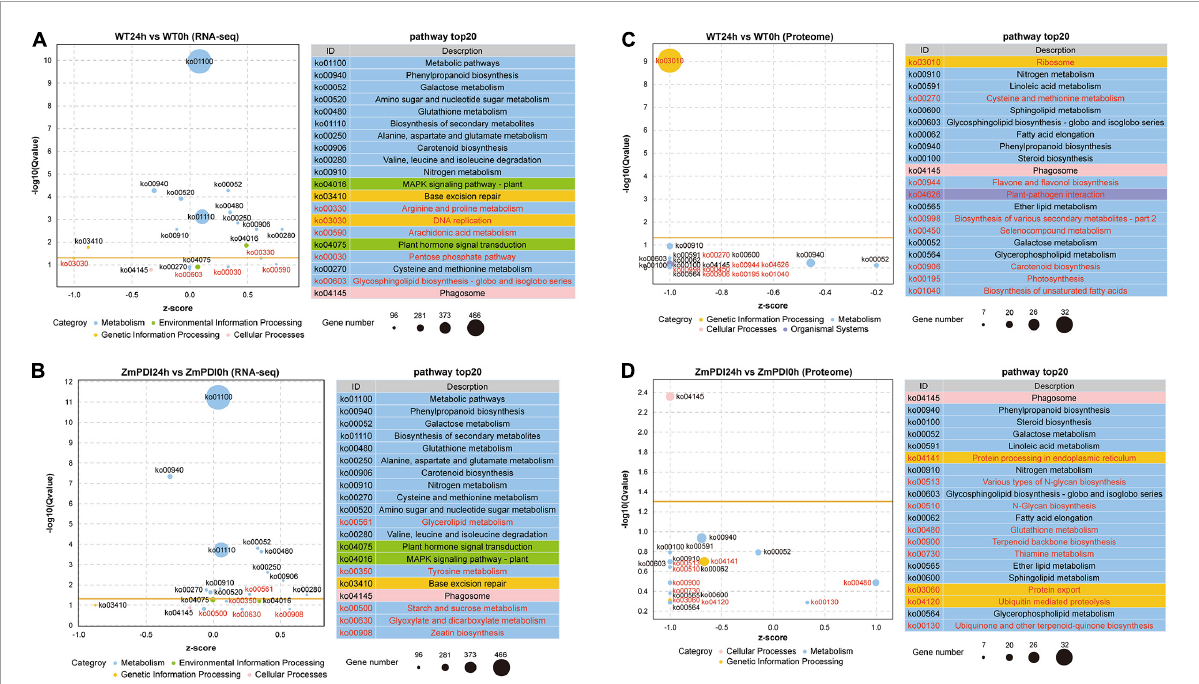
FIGURE4 Top 20 enriched GO terms of DEGs and DEPs in OX-ZmPDI transgenic and WT plants of Z. matrella . (A) Top 20 enriched KEGG pathways of DEGs in the WT24h vs. WT0h comparison. (B) Top 20 enriched KEGG pathways of DEGs in the ZmPDI24h vs. ZmPDI0h comparison. (C) Top 20 enriched KEGG pathways of DEPs in the WT24h vs. WT0h comparison. (D) Top 20 enriched KEGG pathways of DEPs in the ZmPDI24h vs. ZmPDI0h comparison. The z -score value represents the ratio of the difference between the numbers of upregulated and downregulated genes to the total number of differentially expressed genes. The yellow line represents the threshold of Q -value = 0.05.